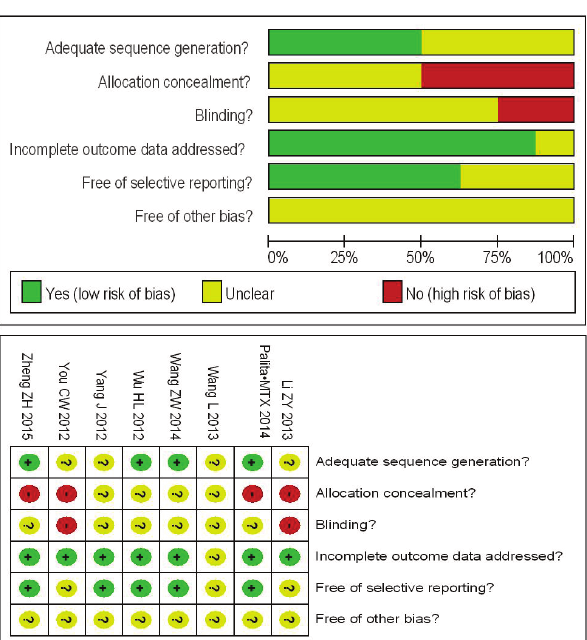
Figure 2: The methodology quality of the included studies, (+:low risk; ?:moderate risk; - high